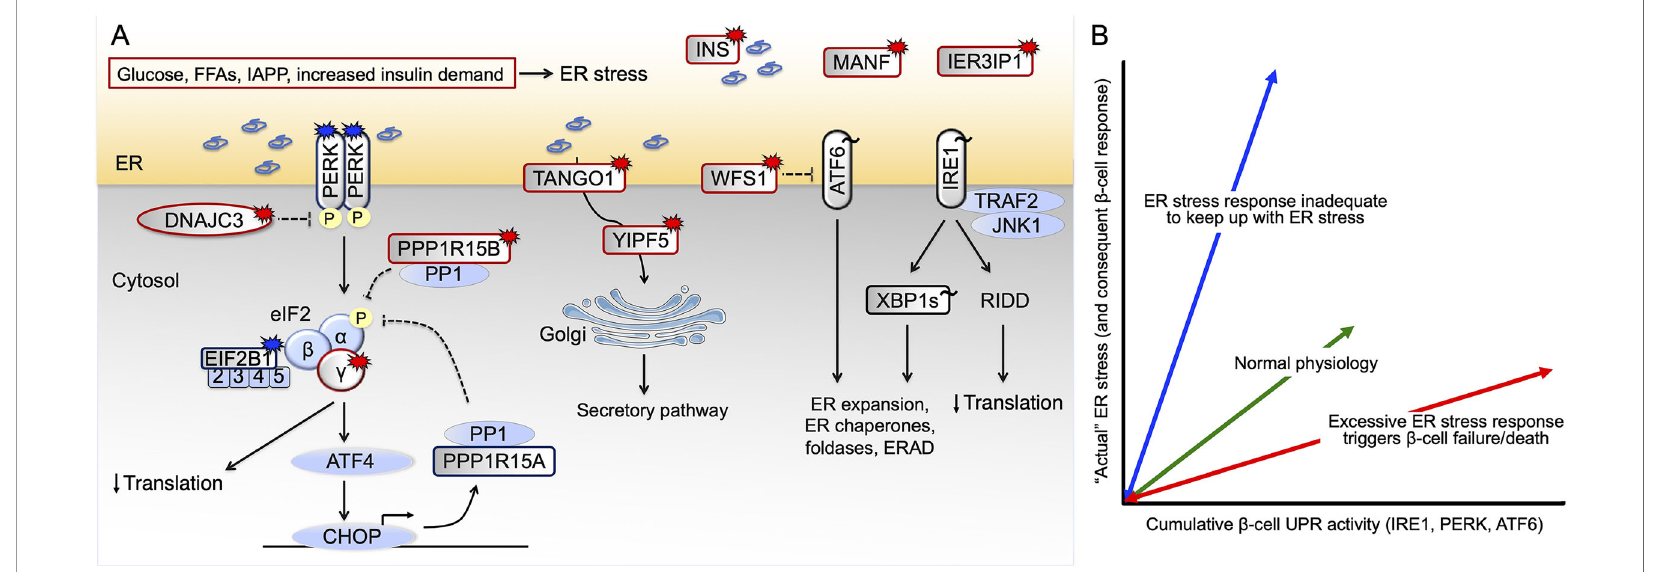
FIGURE 1 | Pathways leading to b -cell ER stress and failure. (A) Genetic and non-genetic causes of human b -cell ER stress in diabetes. Patients with EIF2AK3 and EIF2B1 mutations that result in impaired signaling downstream of PERK develop young-onset diabetes, as do patients with EIF2S3, DNAJC3 and PPP1R15B mutations that result in excessive PERK signaling. Homozygous WFS1 , YIPF5 , TANGO1, MANF and IER3IP1 mutations also cause excessive UPR. Burst symbol indicates loss-of-function mutation causing monogenic diabetes, with red color indicating excessive and blue insuf fi cient UPR signaling. For GWAS variants associated with T2D risk (indicated by tilde), the direction of effect is most often not known (black color). (B) Potential dysregulated b -cell responses to nutritional/metabolic challenge. UPR function is required for normal b -cell physiology, sustaining b -cell health and survival (green arrow). In conditions of insuf fi cient UPR signaling relative to the prevailing ER stress (blue arrow), b -cells will fail. Conversely, excessive UPR signaling will cause b -cell dysfunction and death (red arrow). Currently available data provide evidence for both red and blue scenarios taking place in b -cells in T2D. ERAD ER-associated degradation, FFAs free fatty acids, IAPP islet amyloid polypeptide, RIDD regulated IRE1-dependent